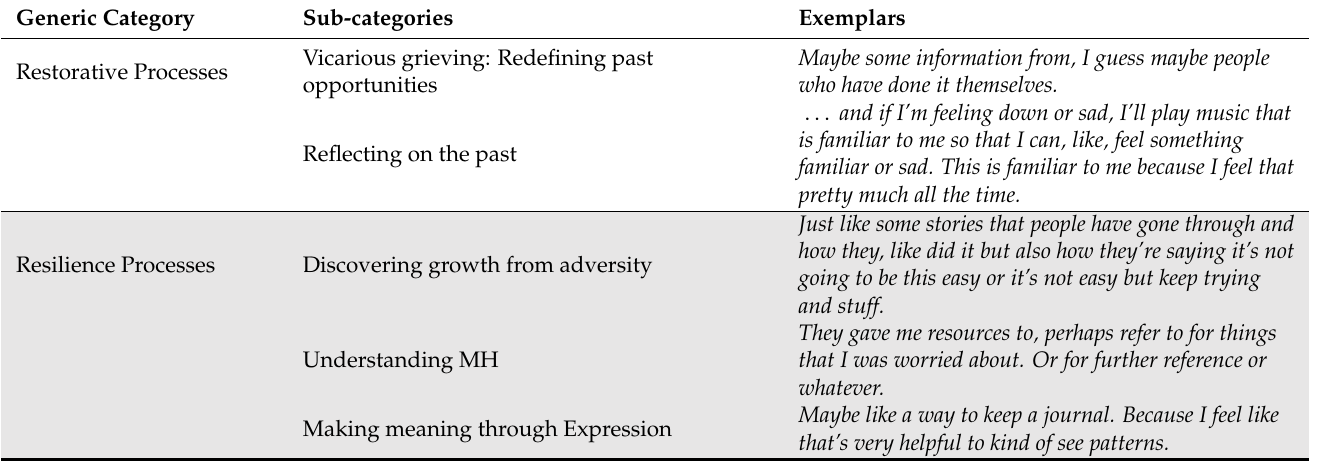
Table 8. Exemplars and categories related to meaning recovery